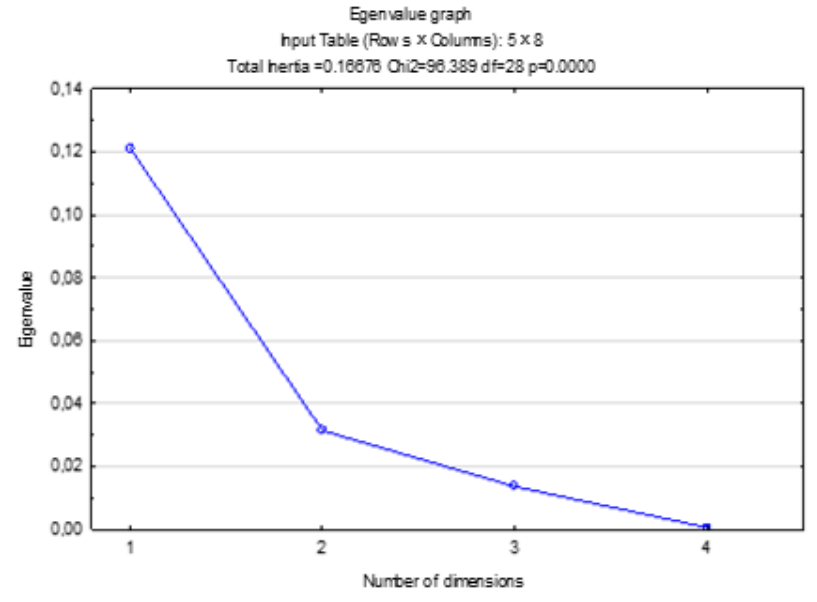
Figure 3. Scree plot of eigenvalues.